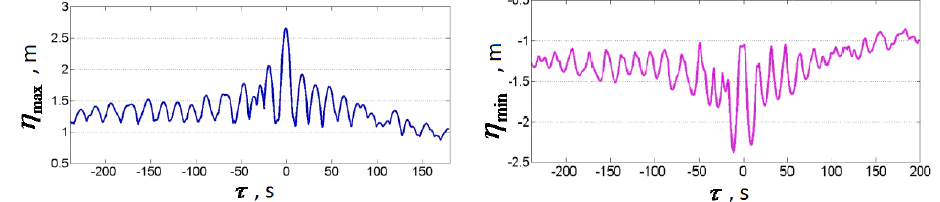
Fig. 6. Maximum values of positive and negative amplitudes versus time